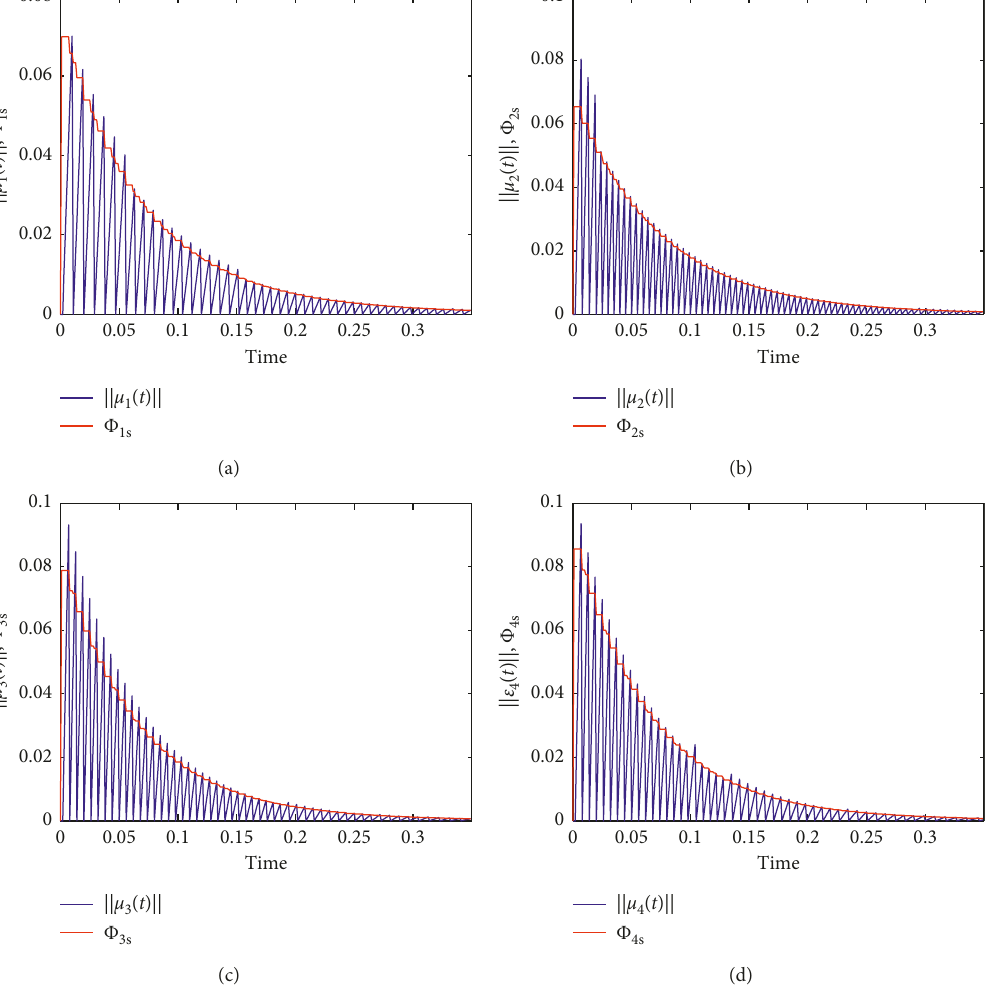
t and the thresholds k ( )